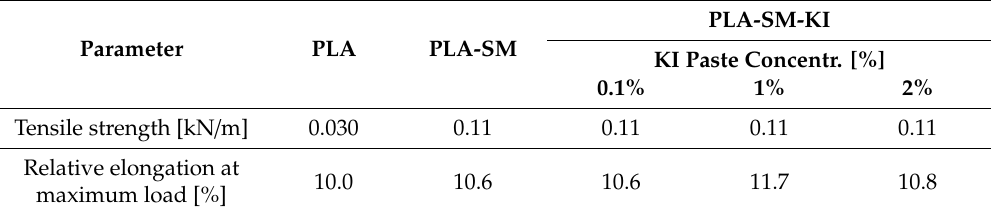
Table 7. Results of tensile strength test of PLA, PLA-SM and PLA-SM-KI (0.1%–2%) composites, according to EN ISO 10319:2015-08 standard. Textiles. [56].